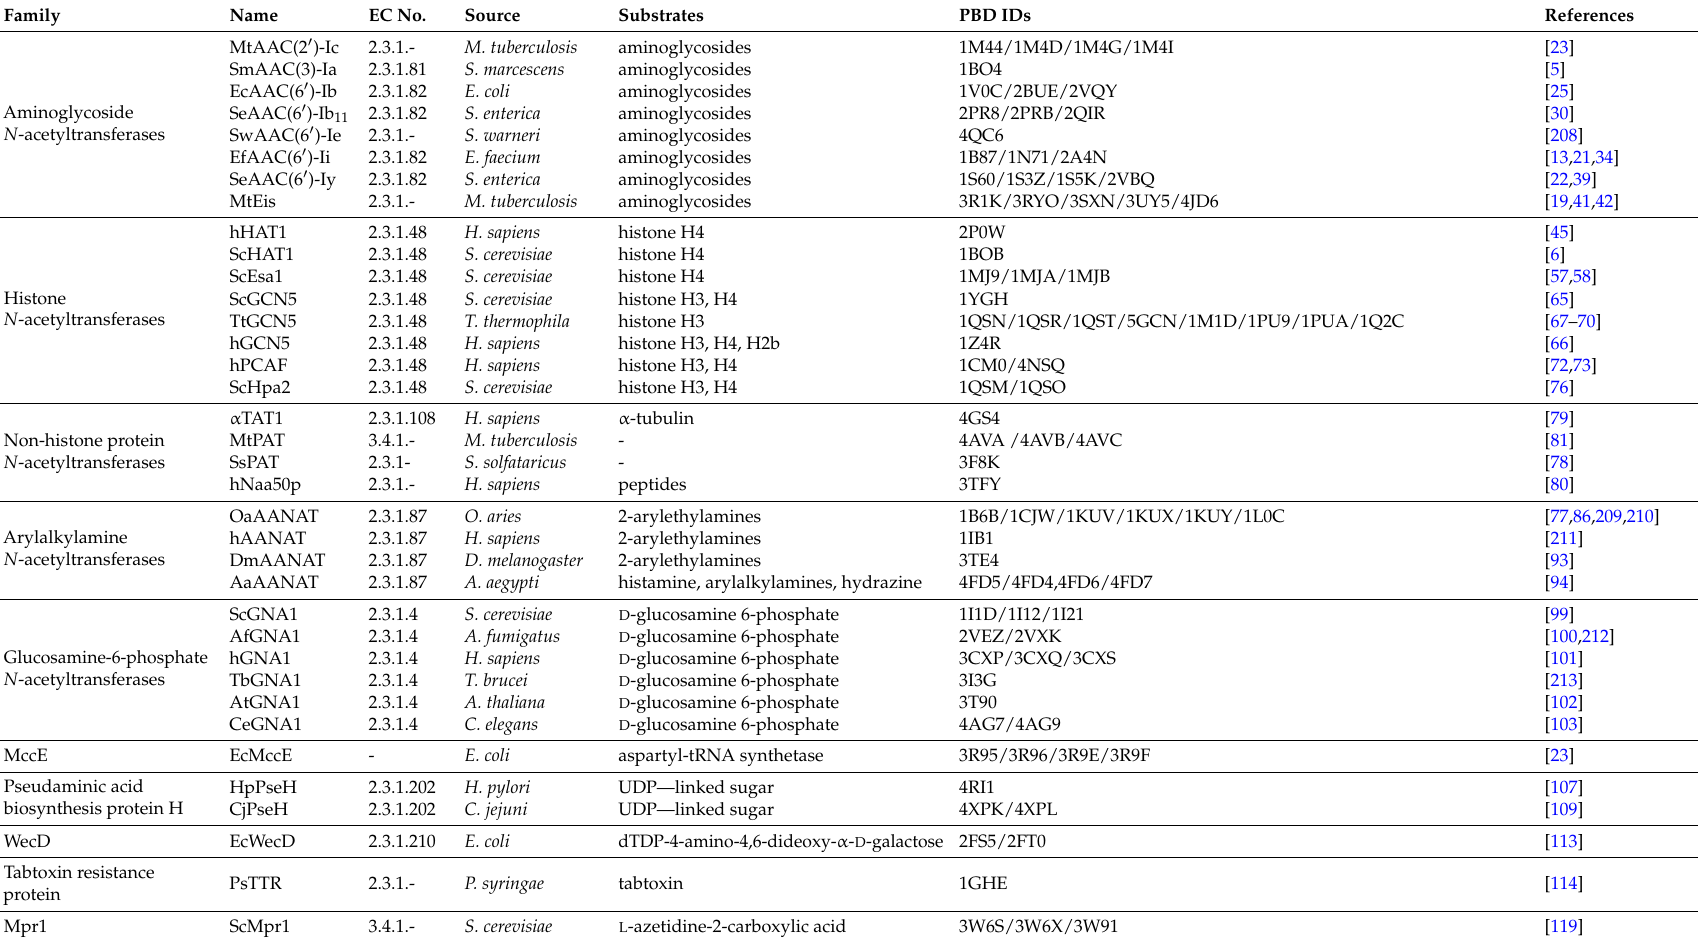
Table 1. General control non-repressible 5-related N -acetyltransferase (GCN5) superfamily members of a known structure (continues on next page).